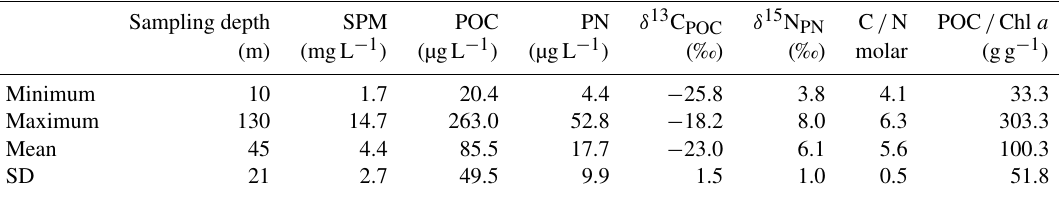
Table 1. Summary statistics of elemental and isotopic compositions, as well as C / N and POC / Chl a ratios, of suspended particulate matter (SPM) around DCM layers in the southern East China Sea ( n = 36). Chl a is the converted value using the linear relationship between measured Chl a and chlorophyll fluorescence. SD = standard